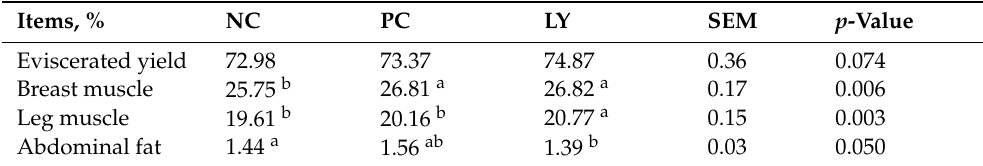
Table 7. Effect of dietary treatments on the carcass traits of broilers.